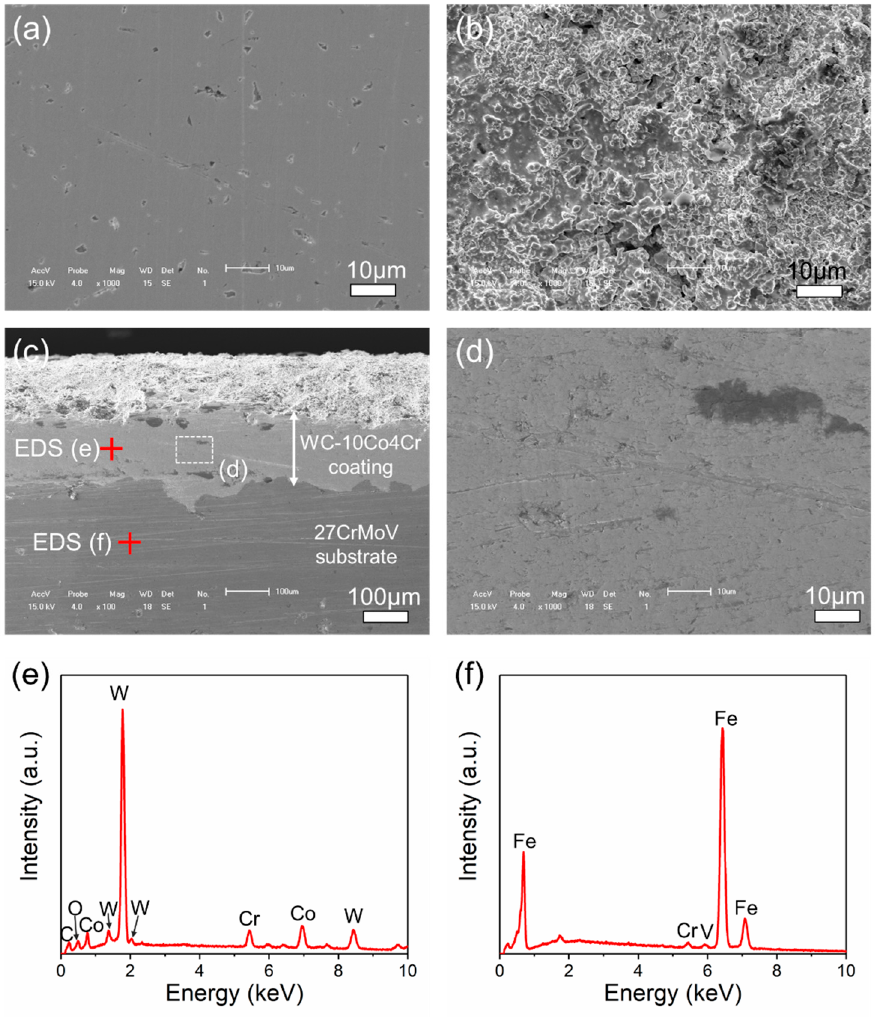
Figure 2. Typical SEM images of surface micro-morphology of ( a ) 27CrMoV substrate and ( b ) WC–10Co4Cr coating. ( c ) SEM images of the cross-section of the WC–10Co4Cr coating and ( d ) the magnified view of the part as marked in ( c ). ( e , f ) EDS patterns of the coating and substrate as marked in ( c ).